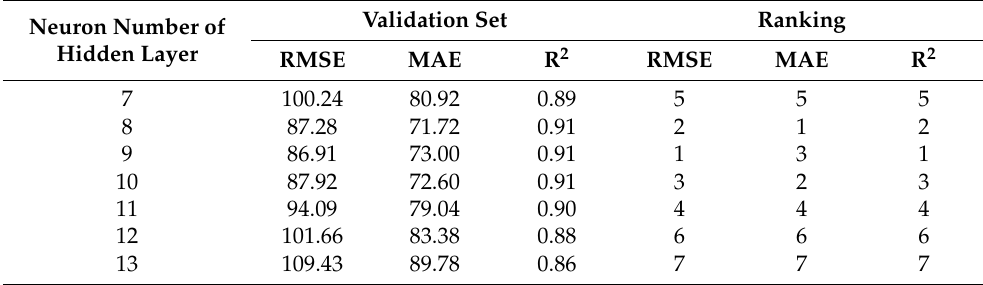
Table 2. Performance and ranking of ANN which have different neuron numbers in hidden layer. Neuron Number